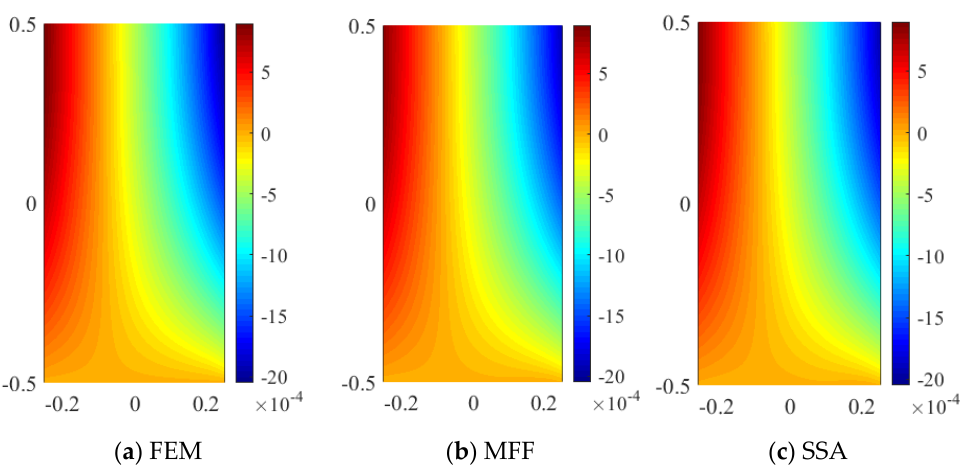
Figure 12. Displacements of u 2 calculated by FEM and improved RBFCM.